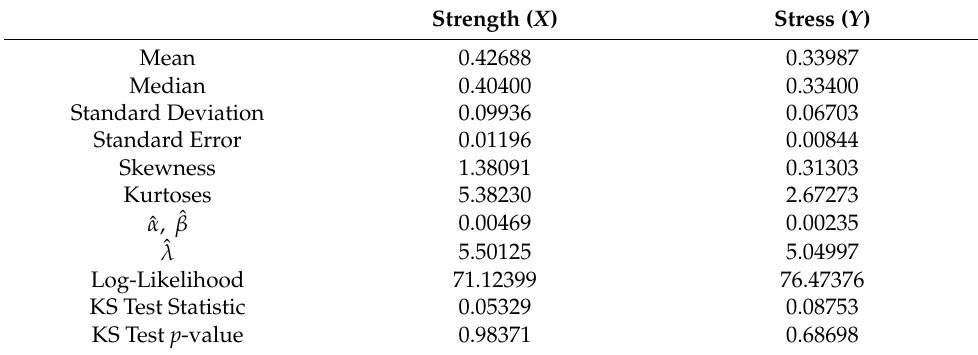
Table 3. Summary Measures for Both Data Sets.